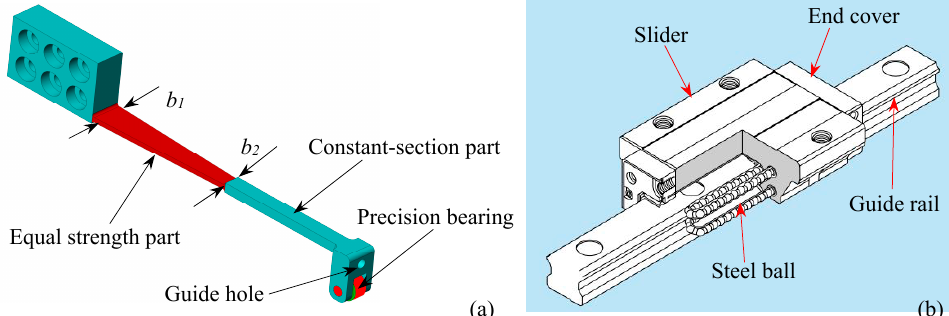
Figure 2. Structure of the proposed sensor.